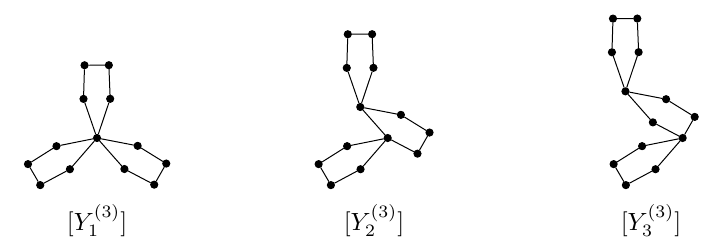
Figure 2. The 3 plane 5-gonal cacti. Each corresponds to the indicated cyclic class [ Y (3) (cid:11) ] of extremal Yangian invariants containing the element Y (3) (cid:11) given in (2.5) or (2.6).